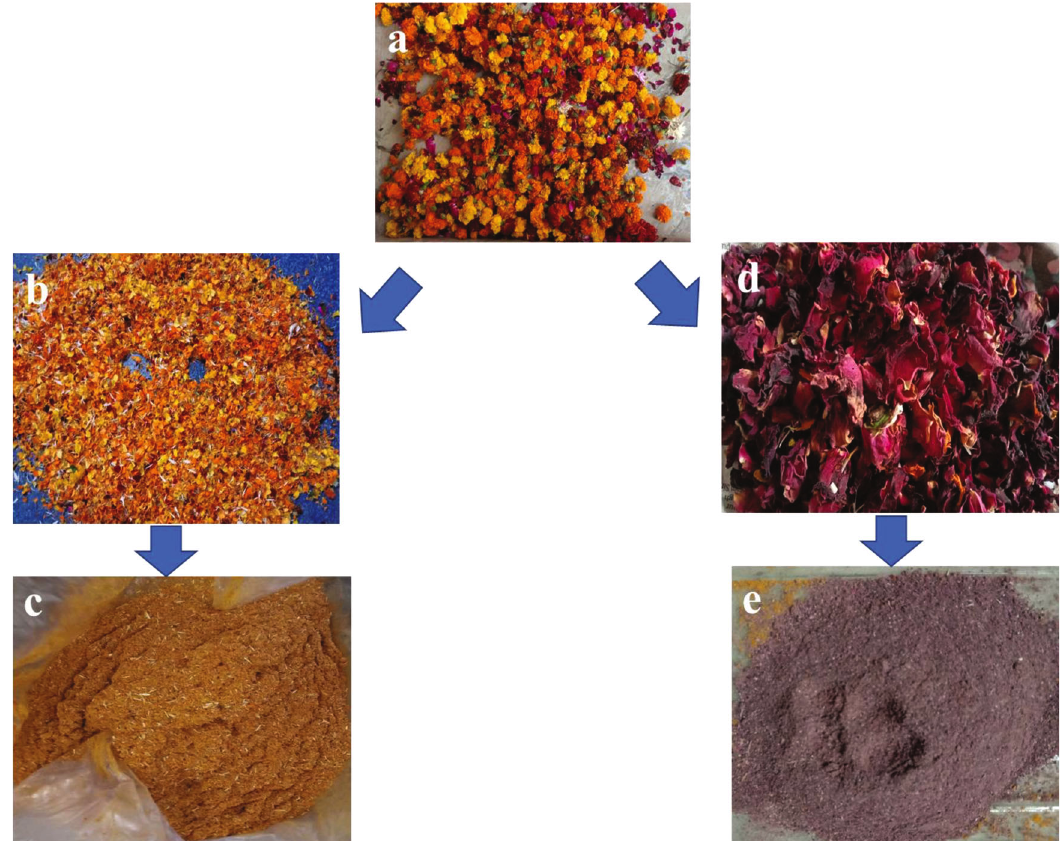
Figure 1: Steps involved in the processing and transformation of fl oral waste into